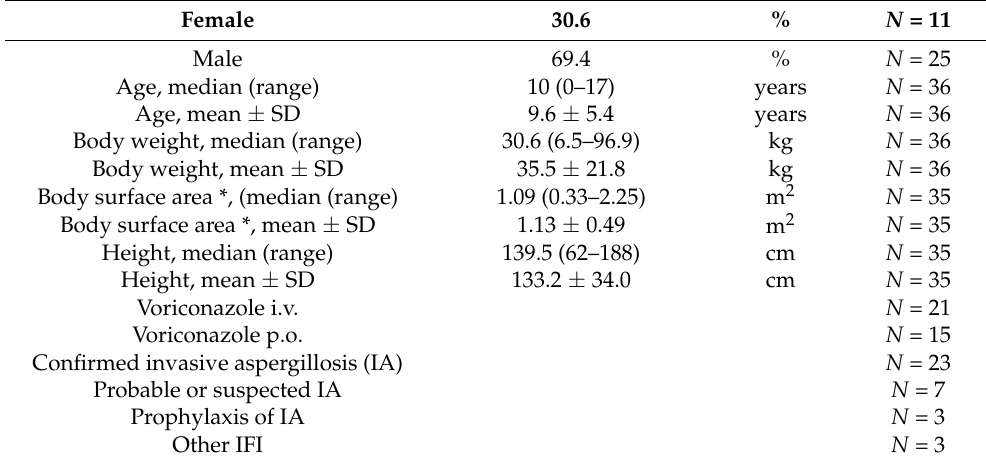
Table 2. Characteristics of the patient population at the beginning of voriconazole therapy. Female 30.6 % N = 11 Male 69.4 % N = 25 Age, median (range) 10 (0–17) years N = 36 Age, mean ± SD 9.6 ± 5.4 years N = 36 Body weight, median (range) 30.6 (6.5–96.9) kg N = 36 Body weight, mean ± SD 35.5 ± 21.8 kg N = 36 Body surface area *, (median (range) 1.09 (0.33–2.25) m 2 N = 35 Body surface area *, mean ± SD 1.13 ± 0.49 m 2 N = 35 Height, median (range) 139.5 (62–188) cm N = 35 Height, mean ± SD 133.2 ± 34.0 cm N = 35 Voriconazole i.v. N = 21 N =